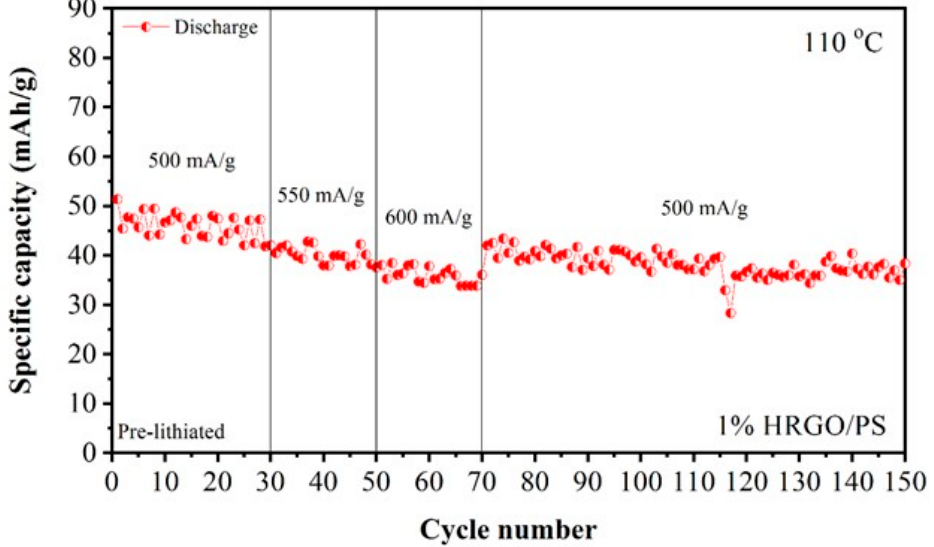
Figure 11. Rate capability at various current densities and cycling performance of 1% HRGO/PS at 110 °C.